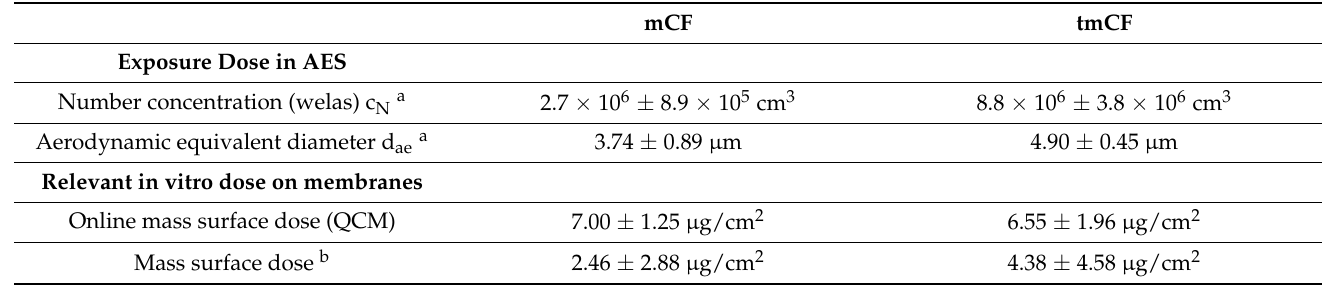
Table 1. Exposure and surface doses of mCF and tmCF in the Aerosol Exposure